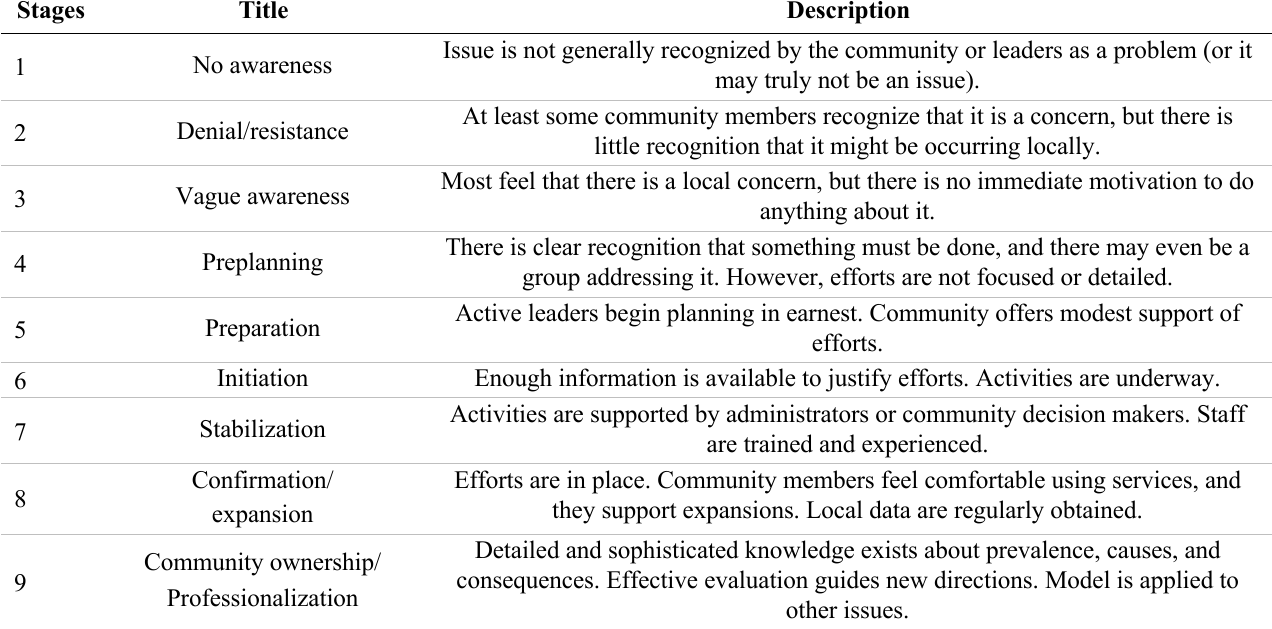
Table 1. Stages of community readiness